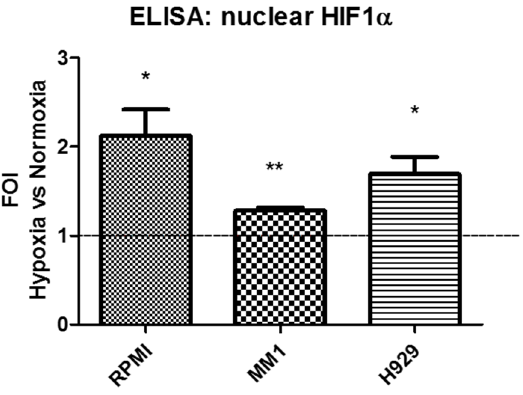
Figure A1. ELISA assay for nuclear HIF1- α indicates that three different multiple myeloma cell lines respond to 24-hour hypoxic chamber stimulation. Values are presented as mean ± SD. Statistical analysis was performed by Student-t test: * p < 0.05; ** p < 0.01.